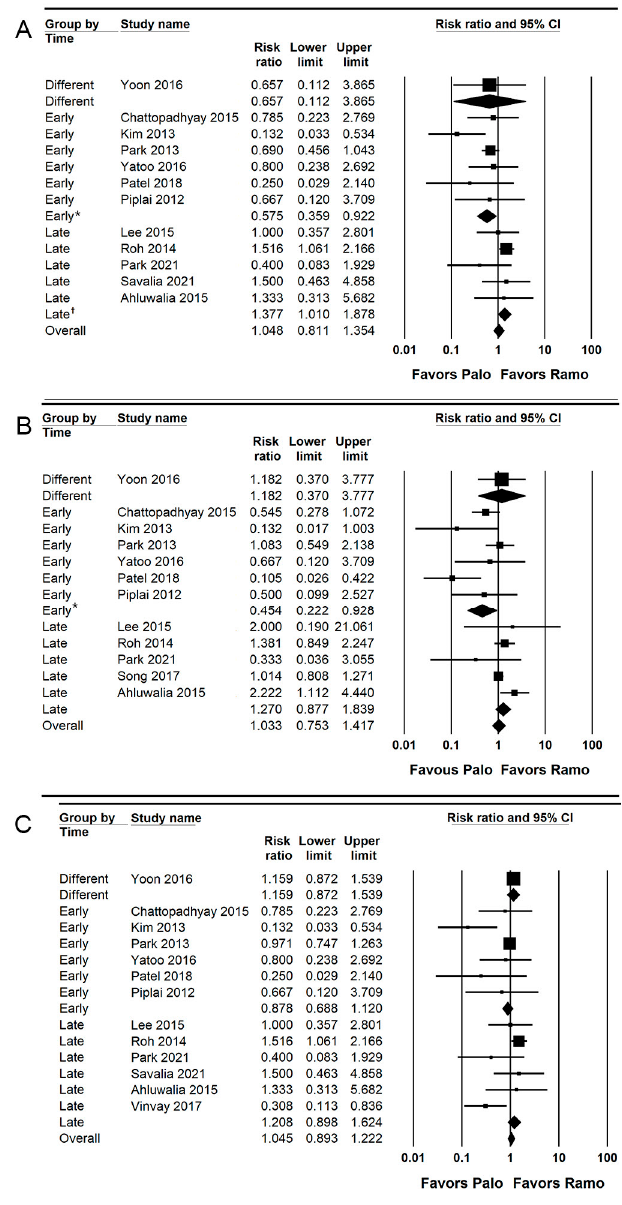
Figure 3. Forest plot of studies comparing the effectiveness of palonosetron with that of ramosetron on PON. ( A ) Early, ( B ) late, and ( C ) overall. The size of the filled squares of risk ratios reflects the effect size of individual trials. Horizontal bars represent 95% confidence intervals of difference. The diamond shape depicted the pooled estimates and uncertainty of the combined effects on early, late, and overall PON. The combined results showed no evidence of differences between palonosetron and ramosetron. For subgroup analysis, the pooled estimates of palonosetron showed that it was more effective than ramosetron in preventing early and late PON when they were administered early (*). Conversely, the pooled estimates of ramosetron indicated that it was more effective than palonosetron in preventing early PON when they were administered late (†).